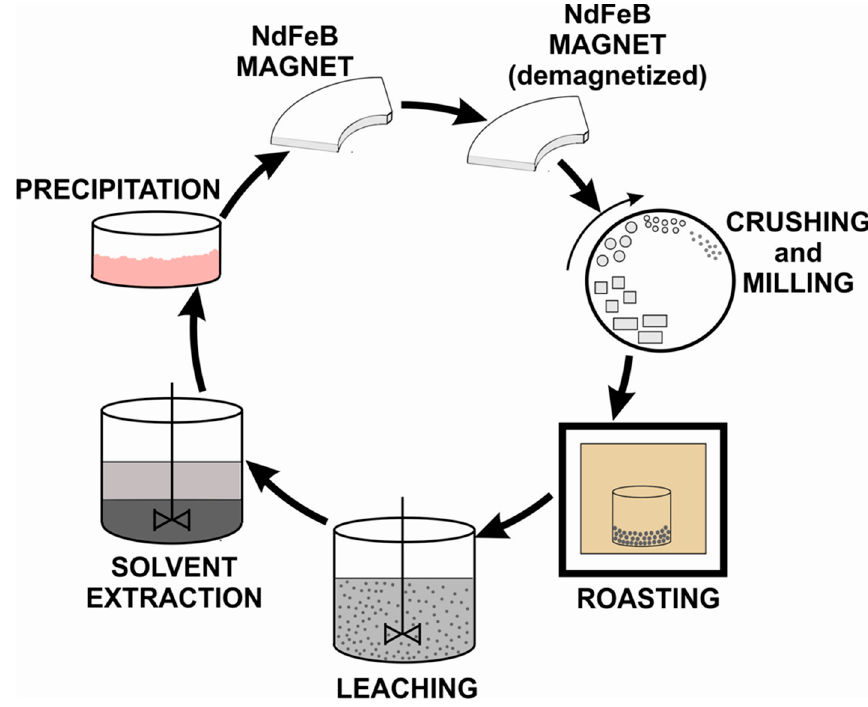
Figure 1. The traditional route of NdFeB magnet recycling using